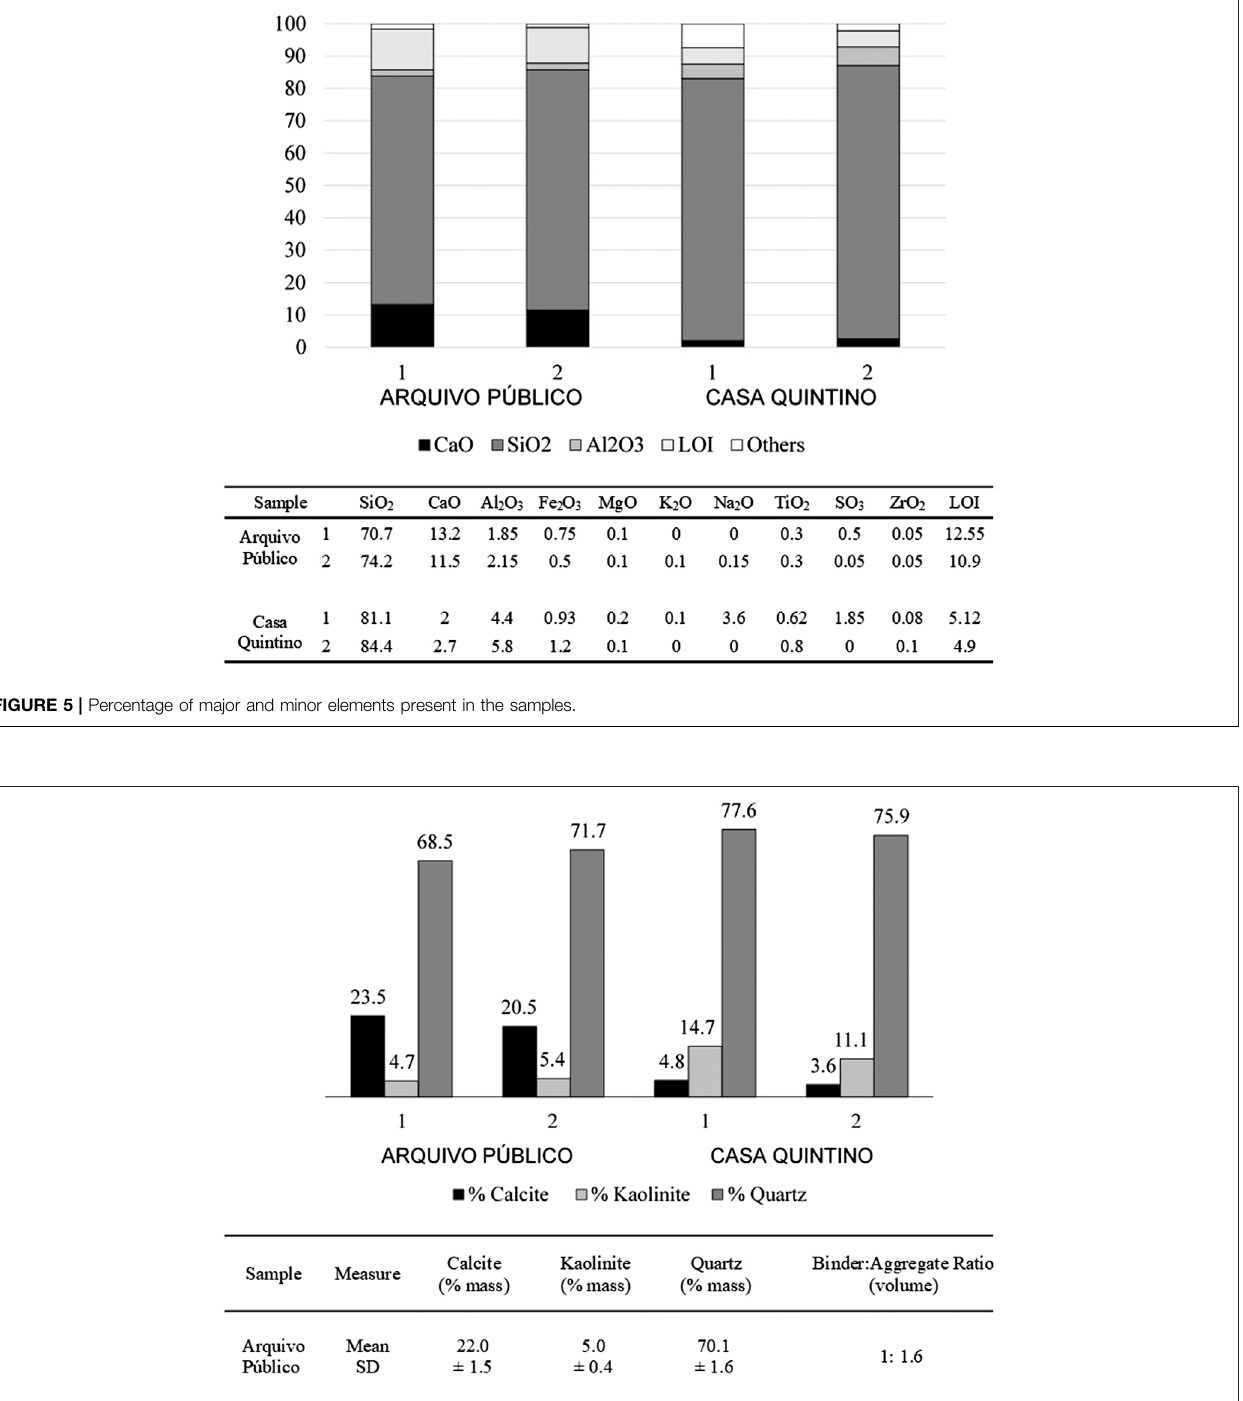
Frontiers in Materials |